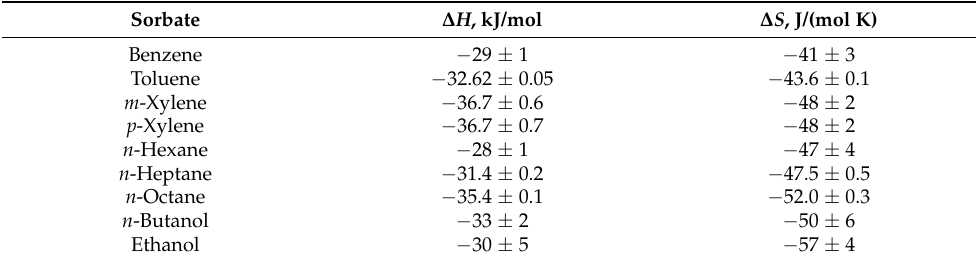
Table 2. Thermodynamic parameters of sorption of hydrocarbons and alcohols in PTBSN after the first stage of heating (170 ◦